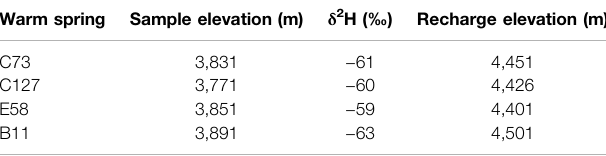
TABLE 2 | Calculated elevation of the recharge areas of warm